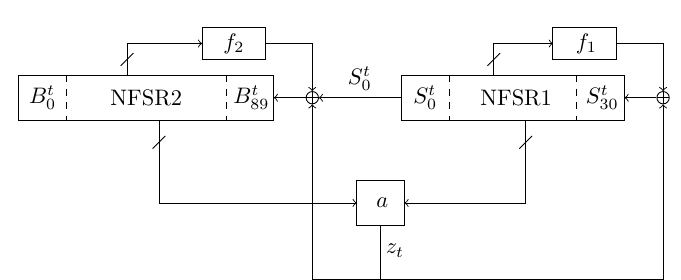
Figure 2: Lizard in phase 2 of the state